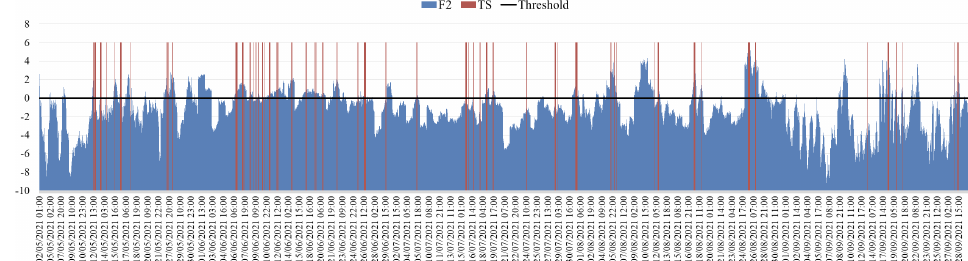
Figure 5. Classification function for GNSS station SOFI (blue bars) and thunderstorm registrations (red bars) from May to September